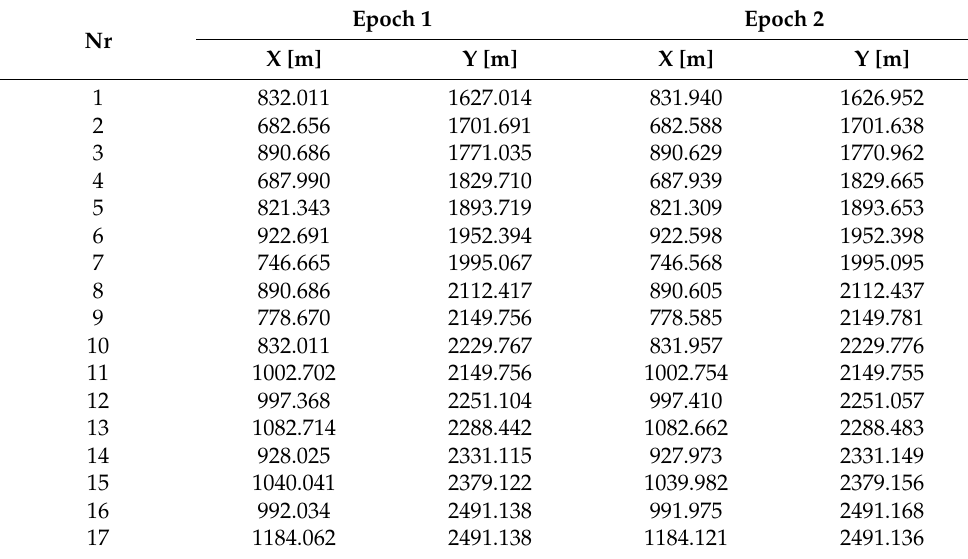
Table 5. Coordinates of points of the test object 2 for both epochs.